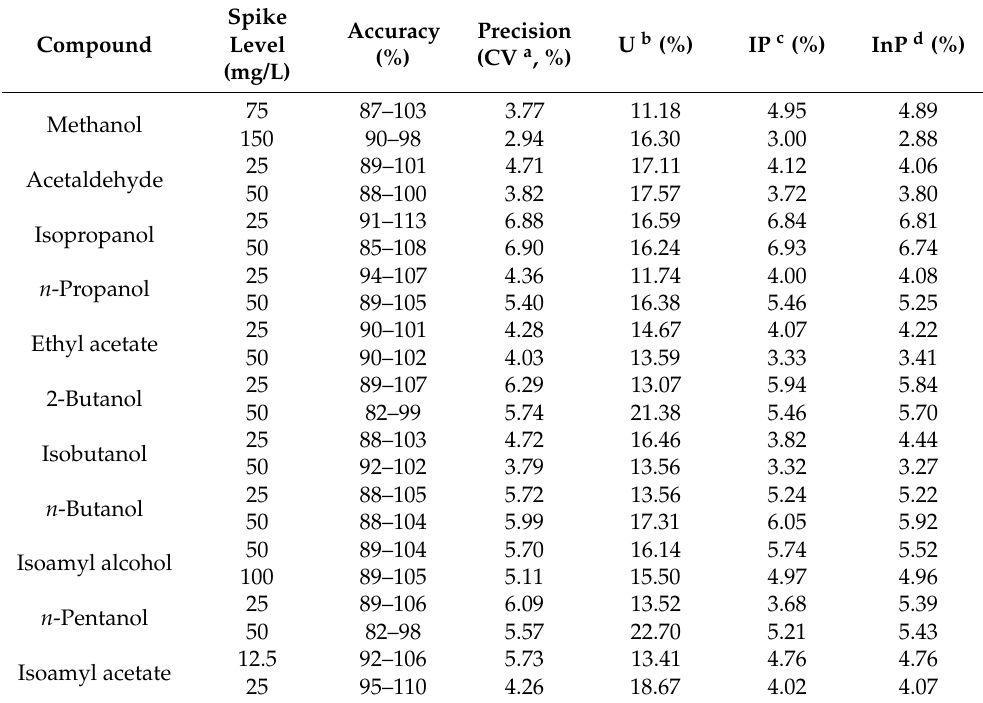
Table 3. Accuracy, precision, uncertainty, inter-day, and intra-day precision of the method.